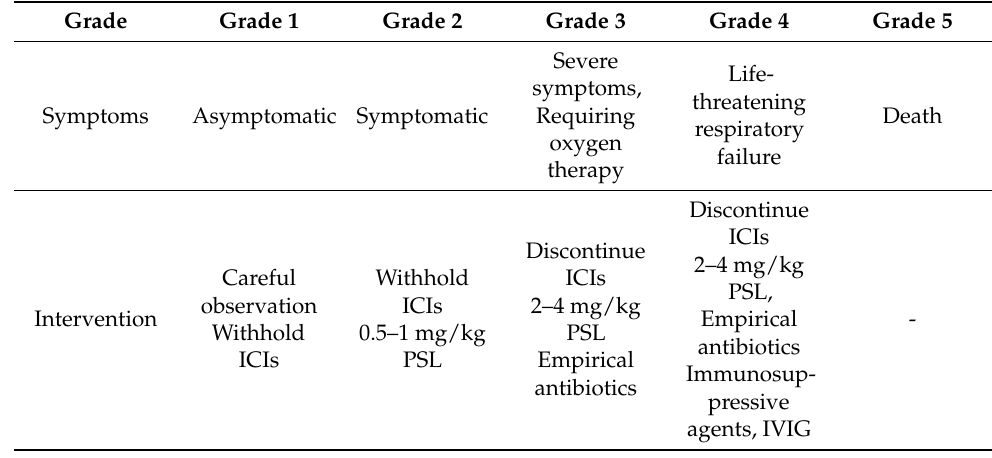
Table 2. Grading of immune-checkpoint inhibitor (ICI)-related pneumonitis and required